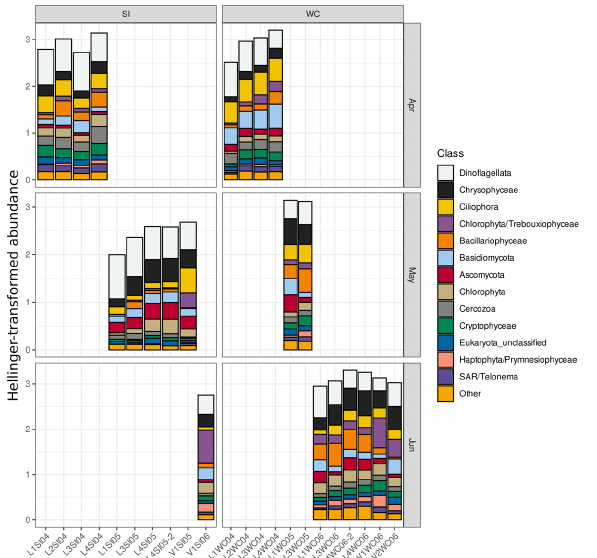
Figure 2. Hellinger-transformed relative abundances of the top-13 microeukaryotic classes in LL and LV communities. The bar stacks are arranged into six facets by two factor variables: “Layer” and “Month”. The profiles are horizontally sorted by sampling site, month and sampling layer. Taxa presented in the color legend are sorted by total abundance in decreasing order, except the last category “Other”. The order of Classes in each bar is the same as in the color legend.